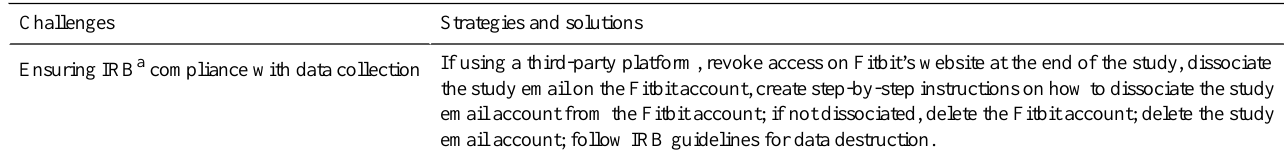
Table 5. Challenges and solutions or strategies for utilizing the Fitbit physical activity (PA) tracker in health interventions at the study closeout stage. Strategies and